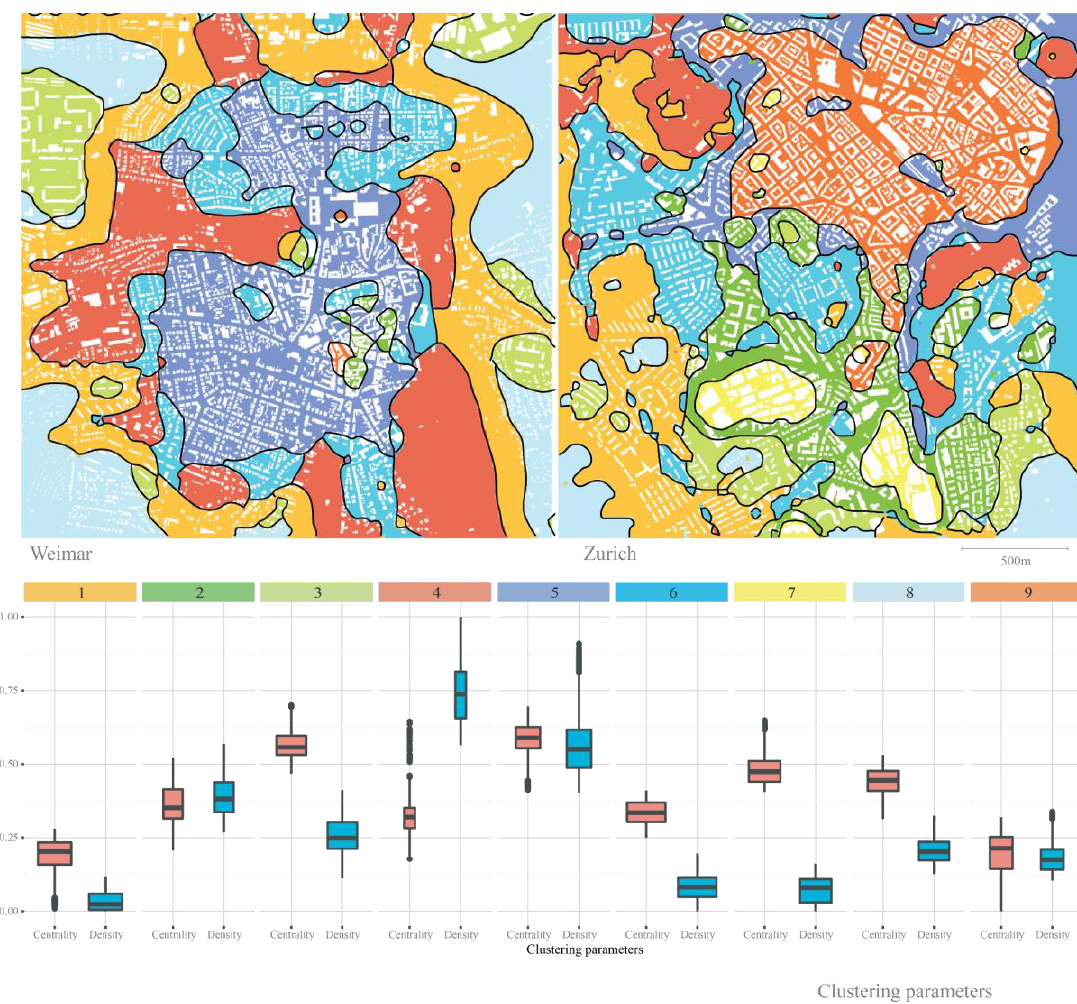
Figure 18. Morphological clusters with box plots displaying the distribution of clustering parameters (i.e., closeness centrality and building intensity density) for each cluster. The box width illustrates number of elements in the cluster.